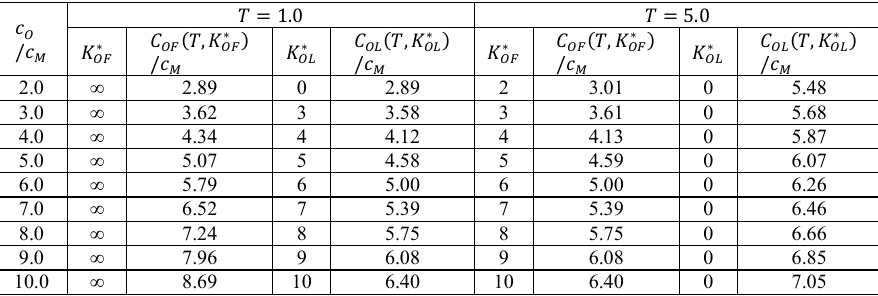
Table 9. Optimum 𝐾 𝑂𝐹∗ and 𝐾 𝑂𝐿∗ and their cost rates for given 𝑇 when 𝐻(𝑡) = 𝑡